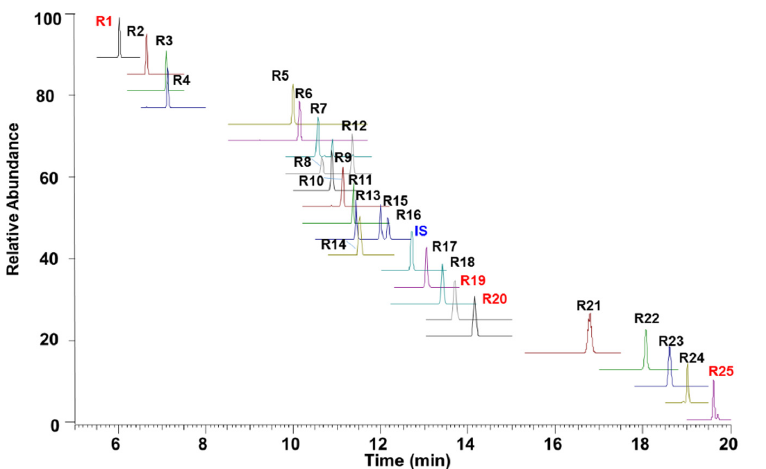
Figure 3. Typical PRM chromatograms of the 25 reference standards. R1 , R19 , R20 , and R25